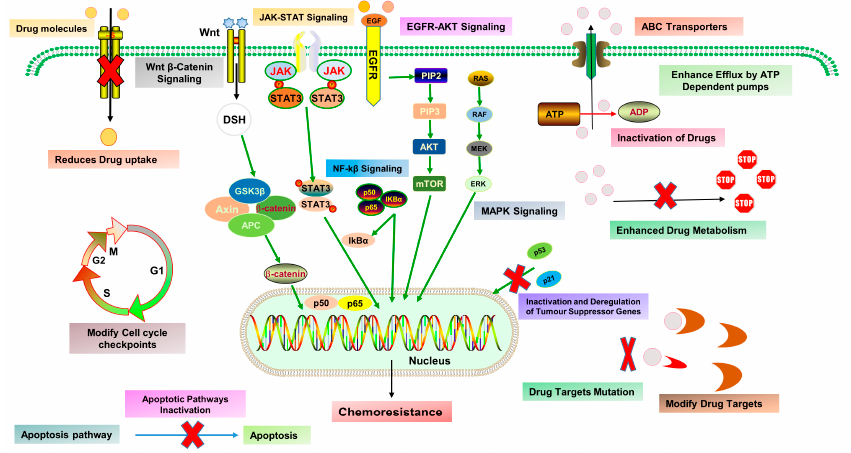
Figure 2. The mechanism of chemoresistance in cancer cells may include a variety of molecular mechanisms, such as regulating drug influx and efflux through ABC transporters, inhibiting cell death, altering drug targets, regulating epigenetic factors, inactivating chemotherapeutic agents, inactivating tumor suppressor genes, modifying DNA repair processes, and modulating growth factor signaling (adapted from [33] , License Number: 5433490420433, License date: 21 November 2022).